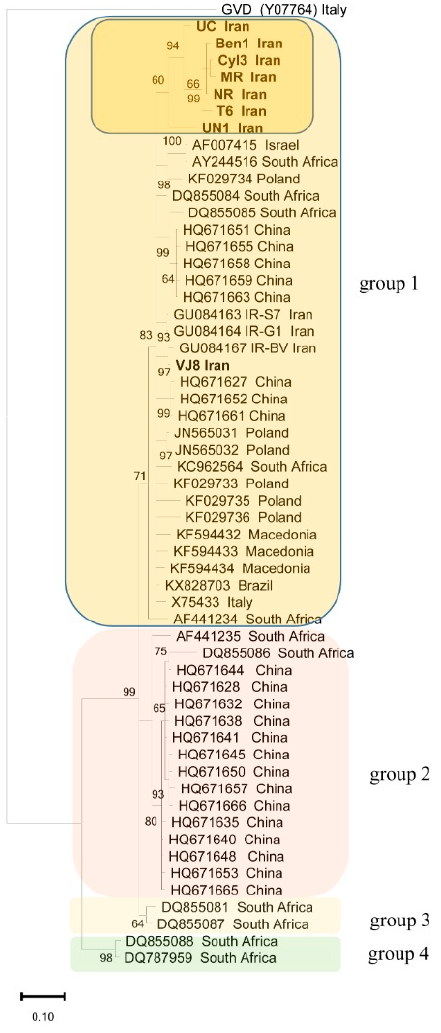
Figure 1. Phylogenetic tree of grapevine virus A (GVA) isolates based on partial nucleotide sequences of the ORF5 gene (236 nt) reconstructed by MrBayes. Bootstrap values (1000 replicates) are given at the branch nodes. Bootstrap values lower than 60 are not shown. Details of isolates are provided in Supplementary Table S1. Grapevine virus D (GVD) was used as the out-group. Iranian GVA isolates are shown in bold within a dark yellow